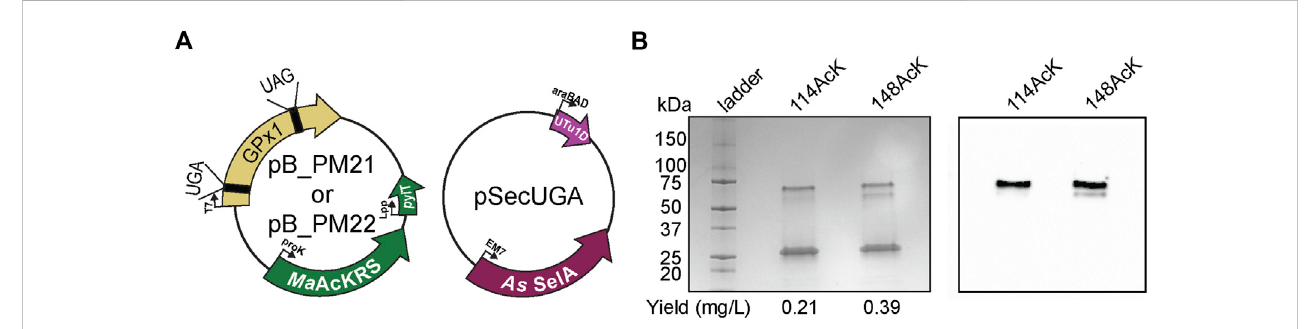
FIGURE 7 Productionofpost-translationallymodi fi edhumanGPx1. (A) Plasmidsusedforinsertionofselenocysteineand N ε -acetyl- L -lysine(AcK)intoGPx1atUGA and UAG, respectively. Two variants were made with AcK at either position 114 or 148. (B) 4% – 20% PAGE shows three bands on the gel for each variant, with thestrongest one atthe25-kDa markercorresponding to monomeric GPx1(24 kDa).An increase inproteinyield wasobservedfor 148AcK.Westernblot with anti-AcK antibody targeted the two higher molecular weight